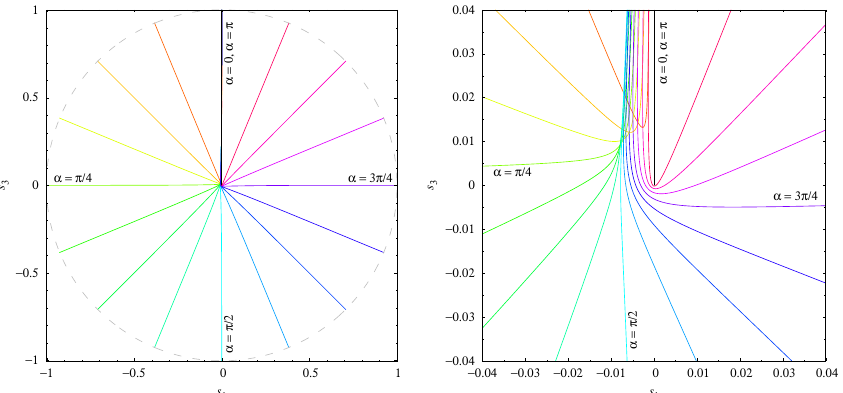
p r n , see eq. (3.6). max